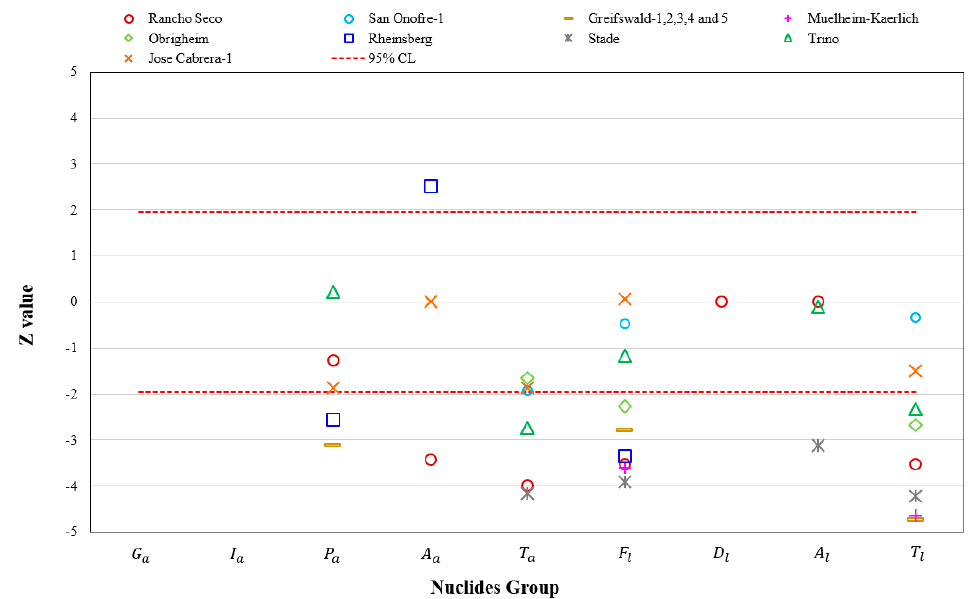
Figure 3. Calculated Z values for annual releases of airborne and liquid radioactive e ffl uents from PS NPPs of which sample size is higher than 10 (i.e., n > 10). The red dotted line indicates the confidence level (CL) of 95%.